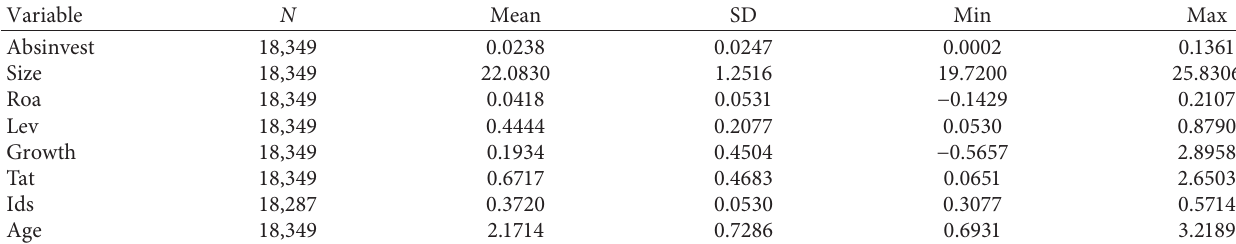
Table 2: Description of the main variables.